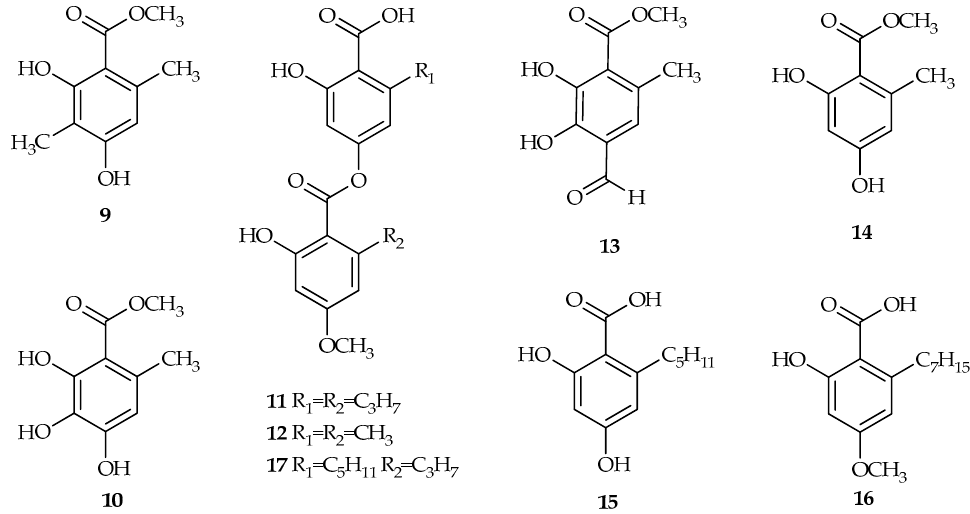
Figure 3. Mono and di-depsides isolated from P. millegarana , P. dilatata and P aurulenta .